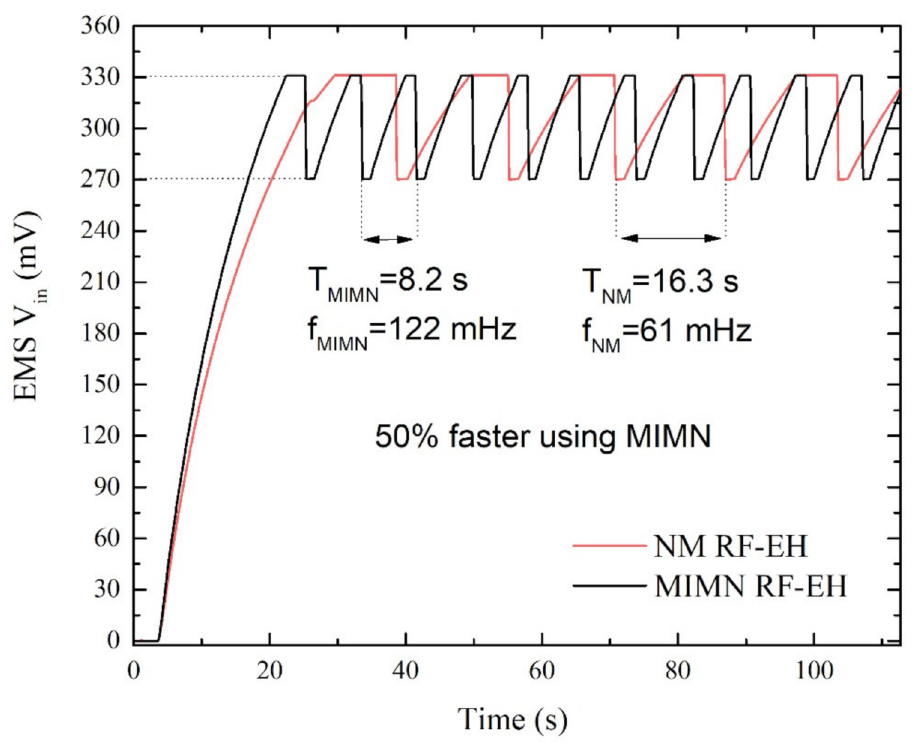
Figure 8. EMS Input voltage transient with (MIMN RF-EH) and without (NM RF-EH) proposed Metamaterial Impedance Matching Network